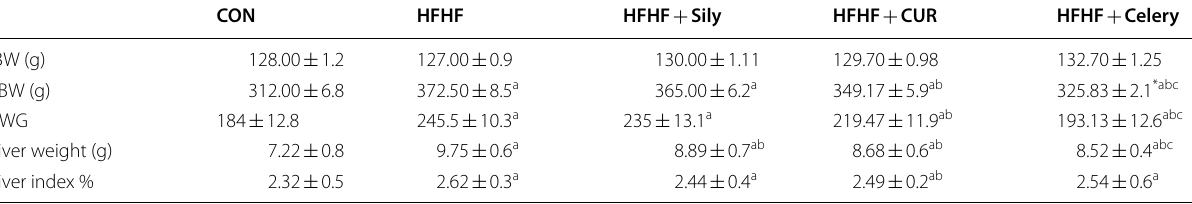
Data represented by mean ɑ p significant difference from control at P < 0.05